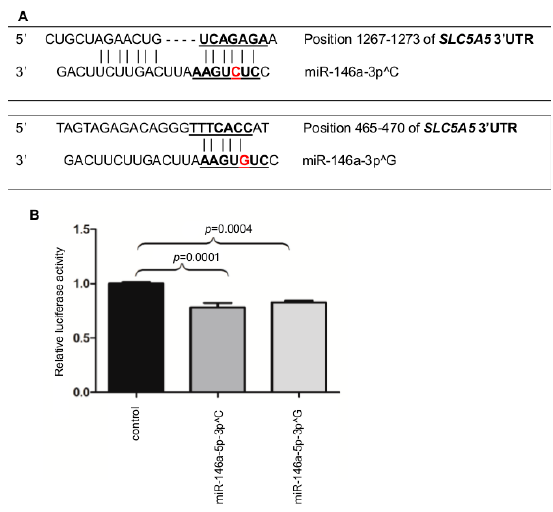
Figure 2. Positions of the putative miRNA binding sites in 3’UTRs of SLC5A5 , identified by TargetScan and miRanda. Nucleotides of perfect complementarity are shown as a seed match ( A ) and the rs2910164 is indicated in red. ( B ) The effect of miR-146a-5p-3p^C or miR-146a-5p-3p^G on the luciferase activity mediated from the NIS 3 ′ UTR is shown relative to control (cells transfected with control miR). The results are normalized to Renilla luciferase and derived from three experiments, each performed in triplicates. Binding of microRNAs to the 3 ′ UTR of NIS resulted in a significant reduction in the luciferase activity for miR-146a-5p-3p^C (22%, p = 0.0001) and miR-146a-5p-3p^G (17%, p = 0.0004). The graphs show the mean, along with deviations from mean (SEM). Statistical analysis was performed using an unpaired t test.